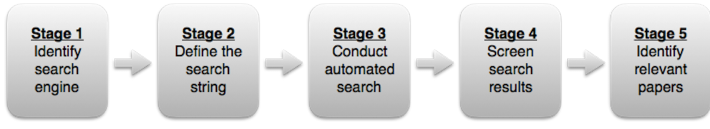
Figure 3. Mapping study stages.